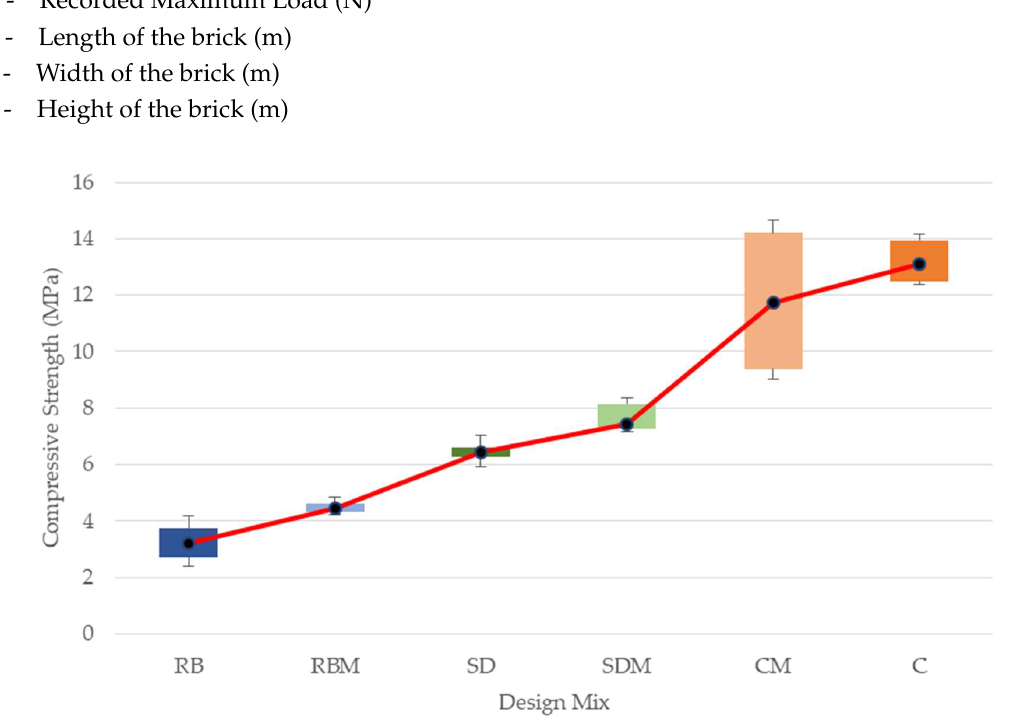
Figure 7. Box and whisker plots of each design mix. Table 2. Average values of the total displacement and flexural